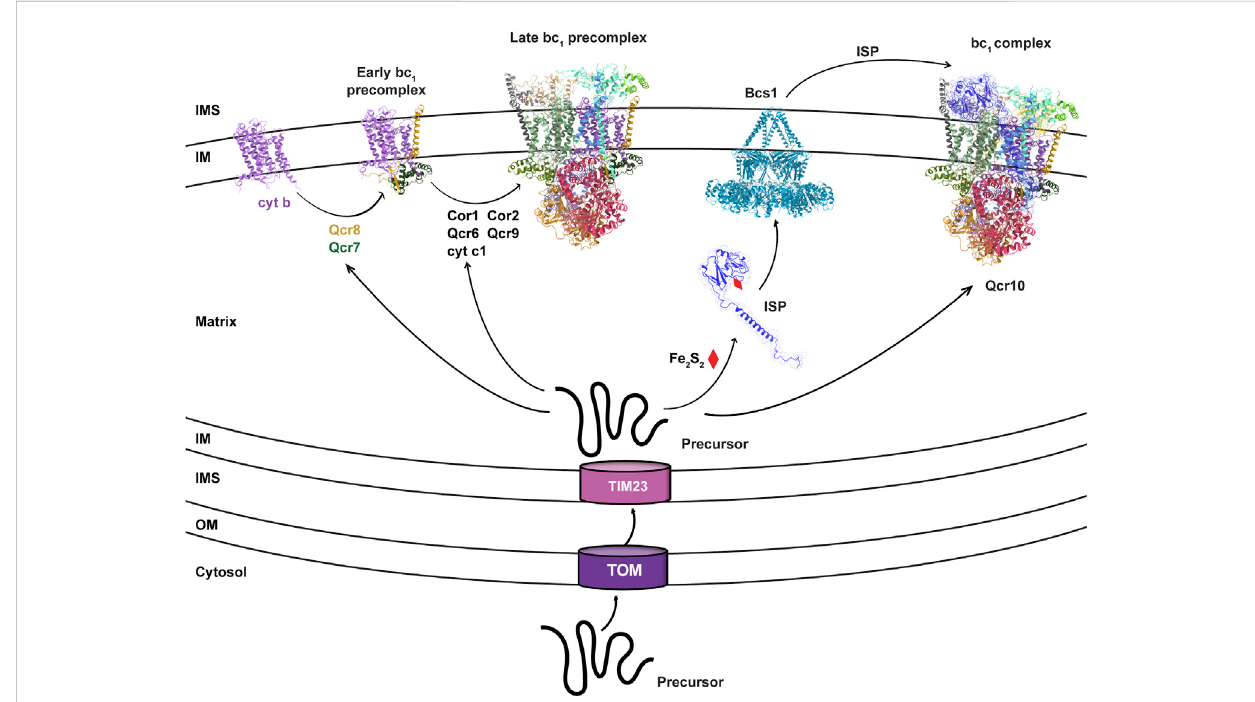
Bcs1 is involved in the late stage of bc 1 complex biogenesis. The biogenesis of yeast bc 1 complex (3CX5.pdb) is shown here to represent the overall process for eukaryotic bc 1 complex. It starts with the translation of mitochondrial DNA encoded cyt b. Via stepwise addition of several non-catalytic subunits and catalytic cyt c1, the biogenesis of bc 1 proceeds from early precomplex to late precomplex. ISP is the last catalytic subunit to be assembled into the bc 1 complex, which is delivered in its folded form to bc 1 precomplex by the translocase